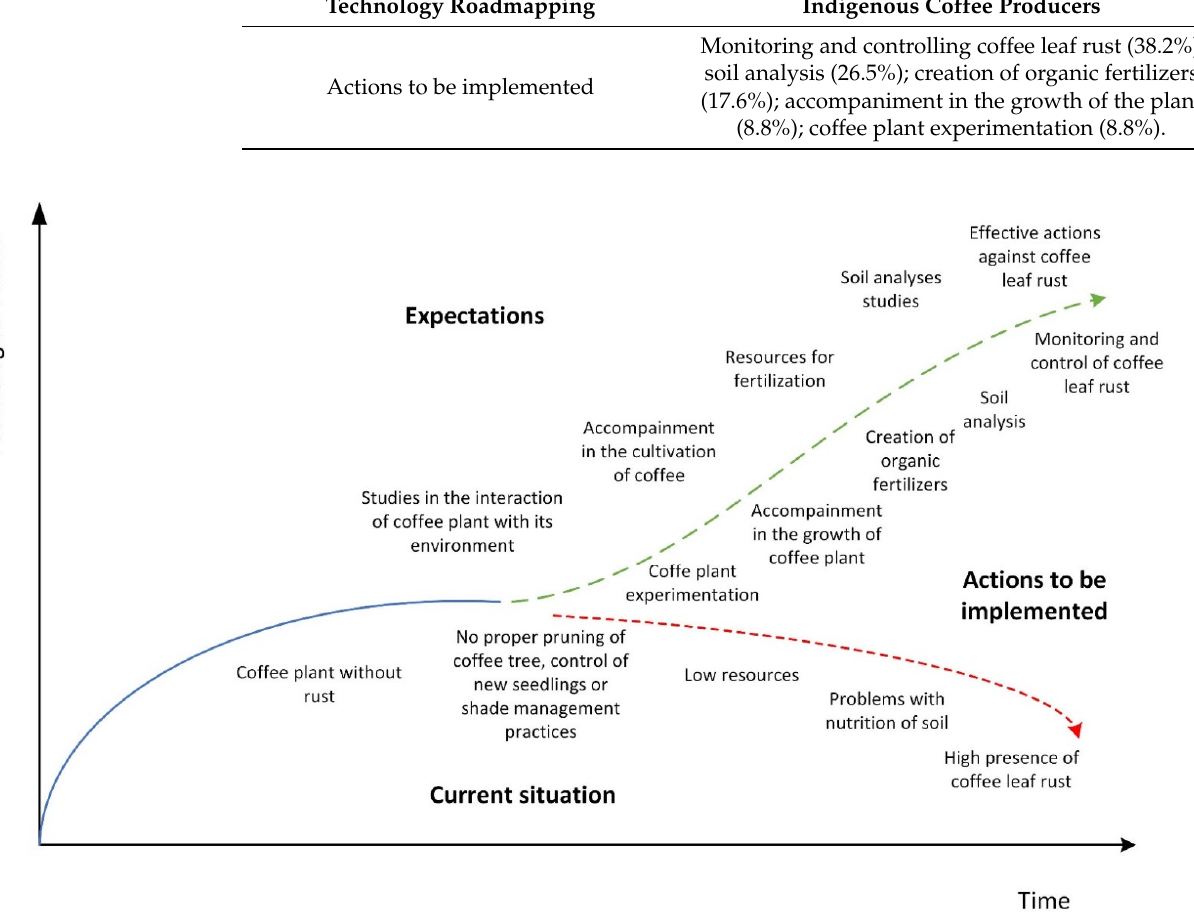
Figure 3. Technology routes.